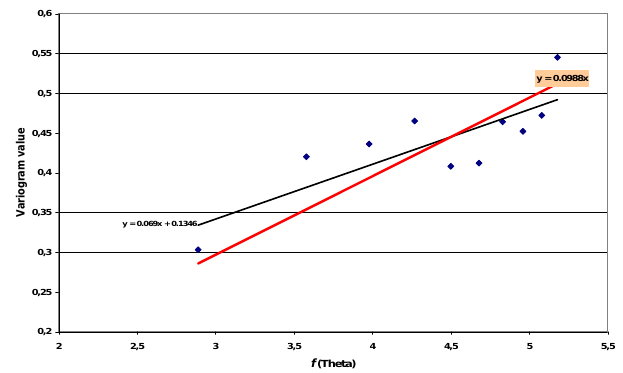
Fig. 9. Relationship between normalized extension variance ( σ 2 and h / L